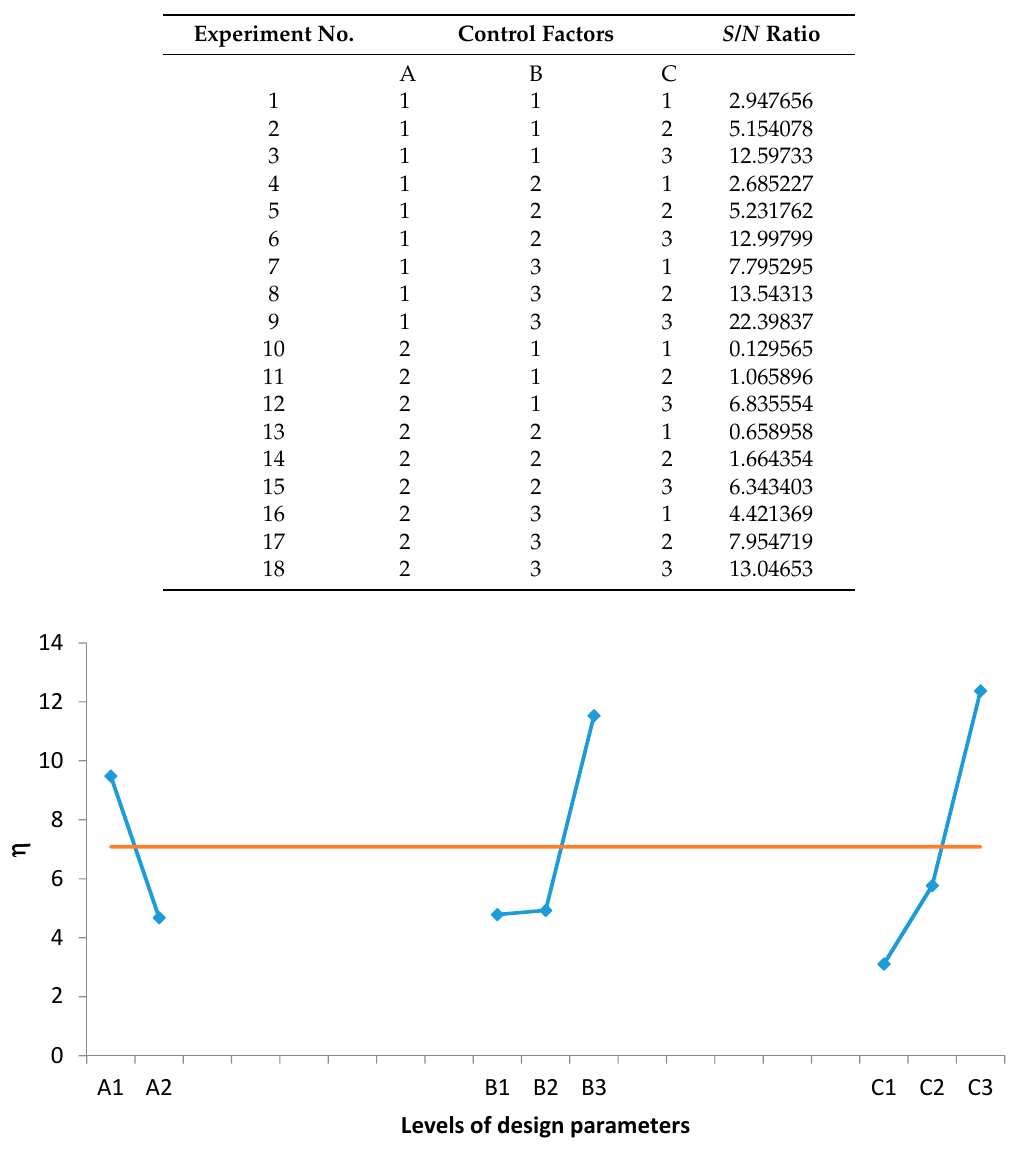
Figure 10. Average η for humidity rate.